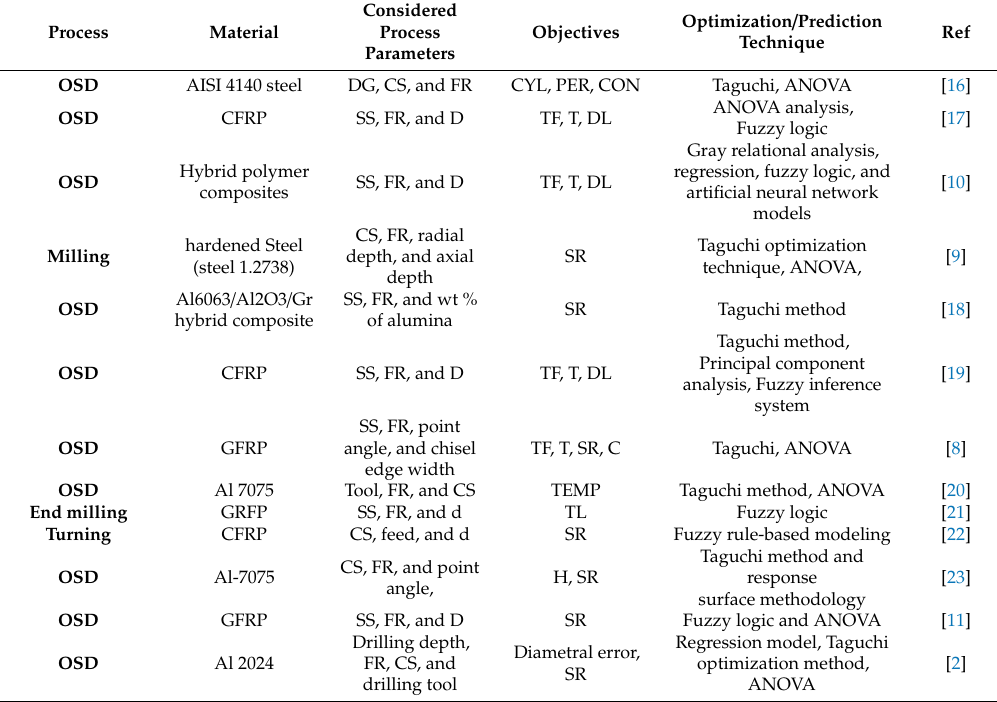
Table 1. Summary of di ff erent optimization techniques used for predicting process parameters in previous machining